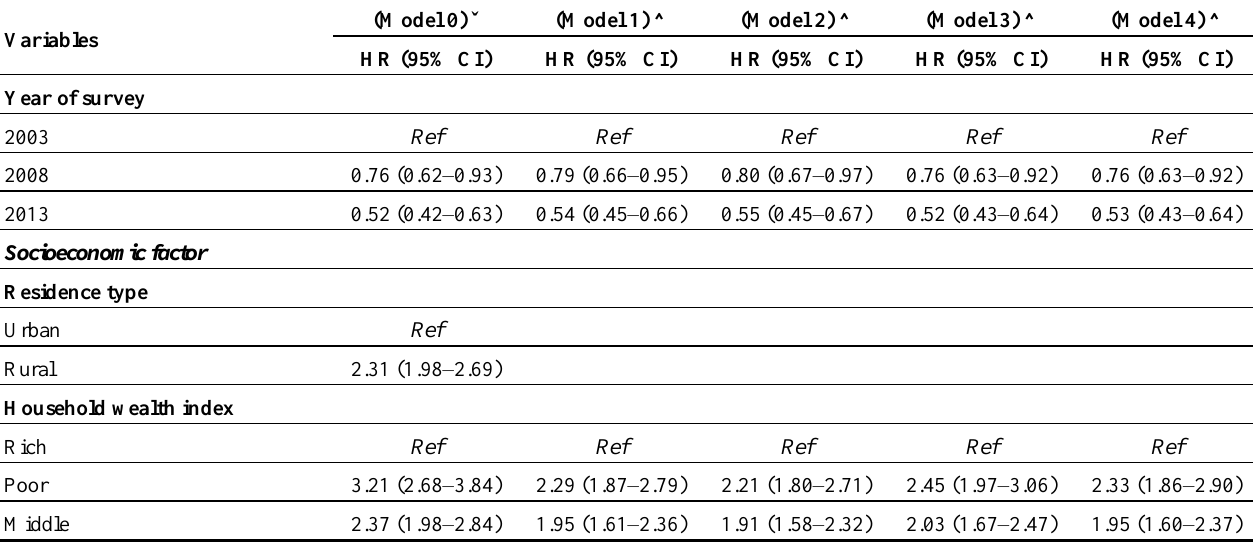
Table 5. Model for child